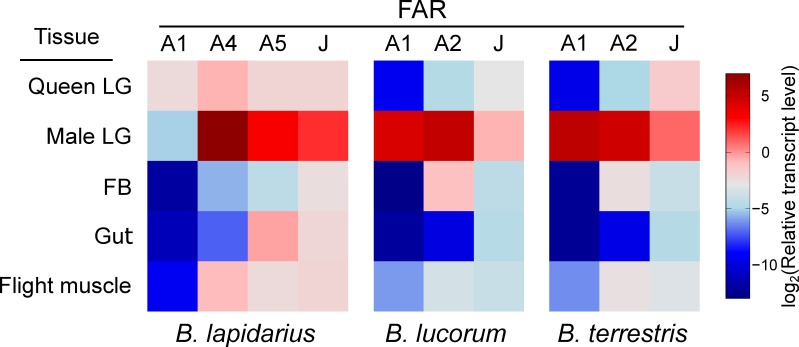
Expression pattern of FAR candidates across bumble bee tissues.The FAR transcripts were assayed using quantitative PCR on cDNA from tissues of 3-day-old B. lapidarius, B. lucorum and B. terrestris males and queens (N = 3; queen LG: one biological replicate represents tissues from two queens).10.7554/eLife.39231.016Figure 4—source data 1.List of Cp differences for FAR transcripts.The file contains a list of Cp difference values for all assayed FAR transcripts. See Figure 4—figure supplement 1—source data 1 for Cp values.